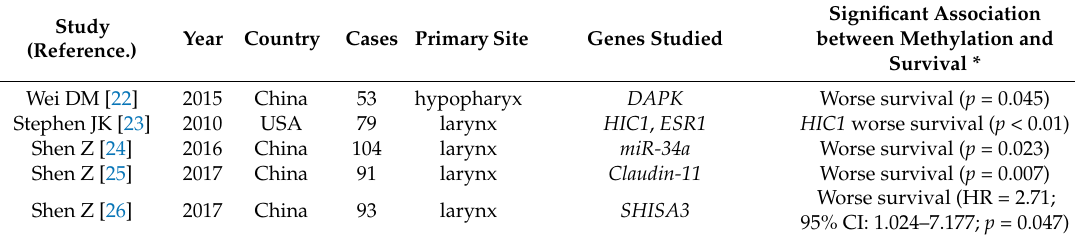
Table 3. Published studies of TRG hypermethylation and survival of hypopharyngeal cancer, laryngeal cancer, and oral cavity cancer